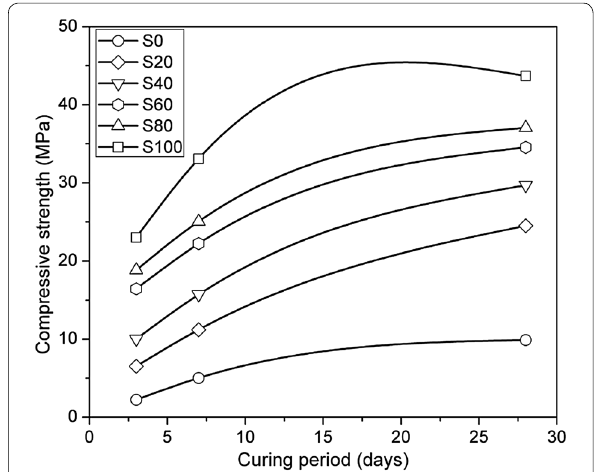
Fig. 6 Variation in compressive strength with curing period.